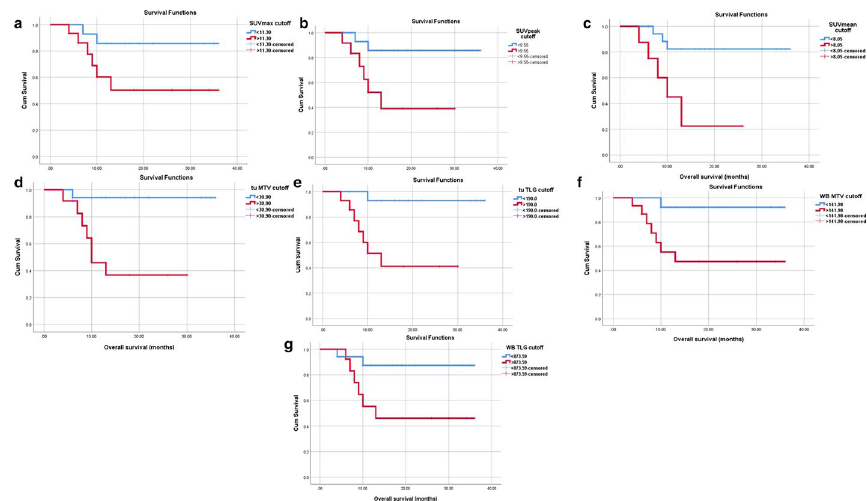
Table 4 Multivariate Cox regression on the association of metabolic and volumetric parameters with OS